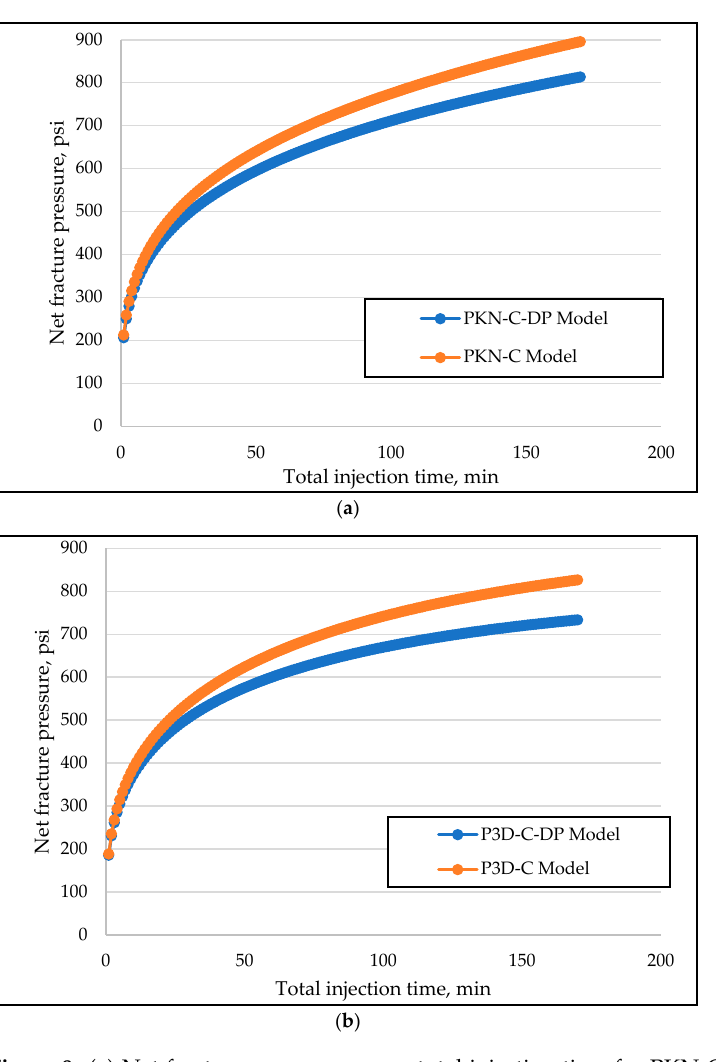
Figure 8. ( a ) Net fracture pressure versus total injection time for PKN-C and PKN-C-DP models; ( b ) net fracture pressure versus total injection time for P3D-C and P3D-C-DP models.